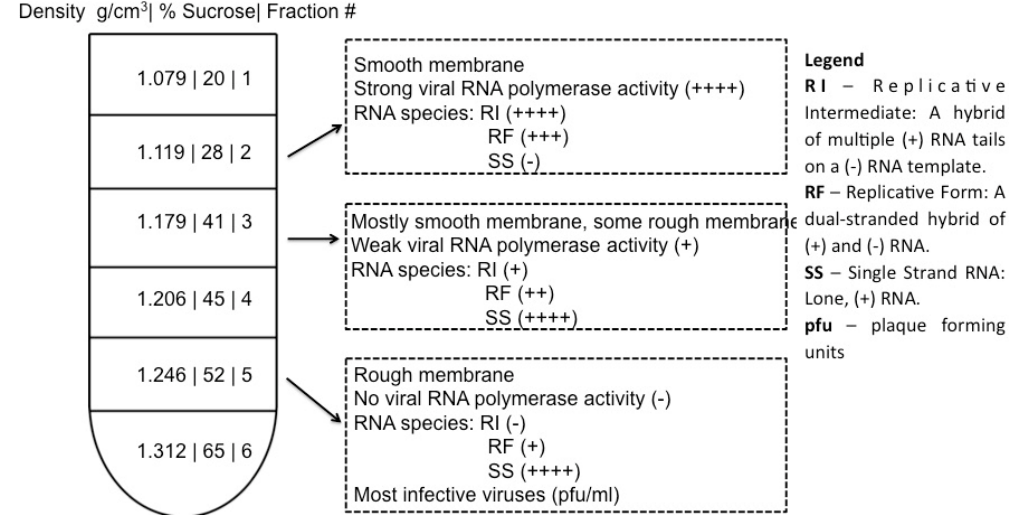
Figure 2. Subcellular fractionation of functionally distinct vesicles associated with replication processes. In work by Caliguiri and Tamm, Dounce homogenates of HeLa cells were layered in a discontinuous sucrose gradient, centrifuged at 86,000x g . Upon fractionation of the gradient, membrane bands with the indicated densities were collected. Properties of fractions 2, 3, and 5 are shown. Vesicle content was examined by electron microscopy [58]; RNA polymerase activity of the isolated fraction was measured by tritiated ATP incorporation; the abundance of RNA species (RI, RF, SS) was determined by gel electrophoresis; and viral titer was measured by plaque assay [58,66]. Note: data from Caliguiri and Tamm [58,66,67].